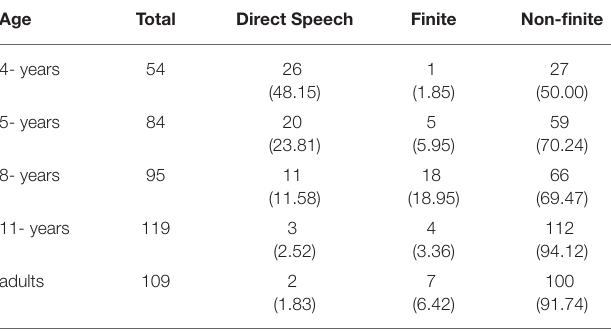
TABLE 2 | Frequency (and percentage) of different types of embedded and/or dependent clauses by age*. Age